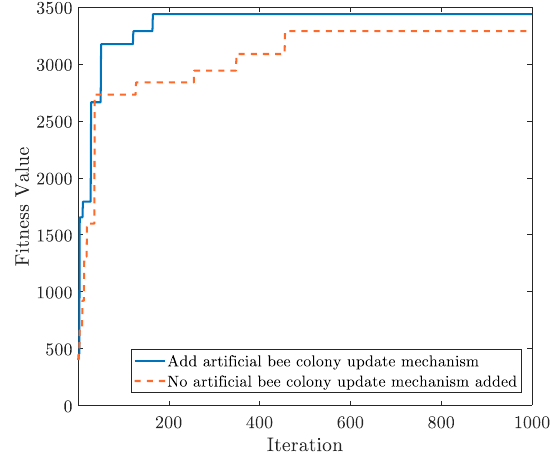
Figure 4. Comparison of artificial bee colony update mechanism.